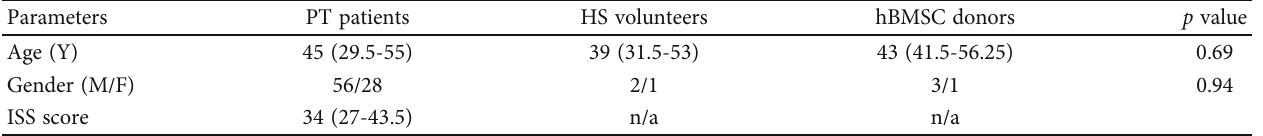
Table 1: List of